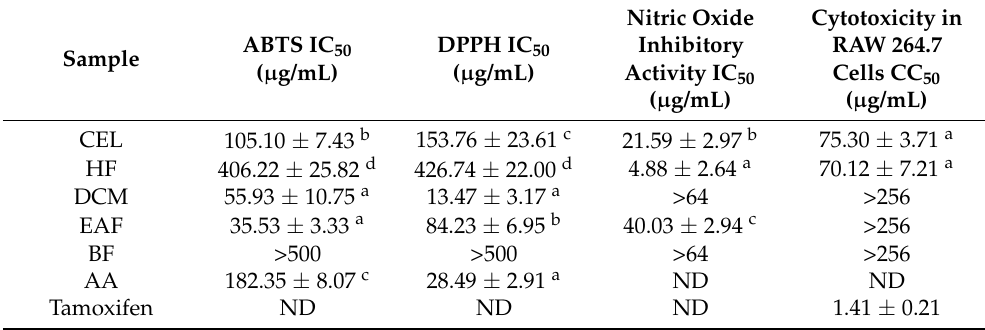
Table 1. DPPH and ABTS radical scavenging activity, NO inhibitory effect and cell viability of C. linearis leaves’ extract and its